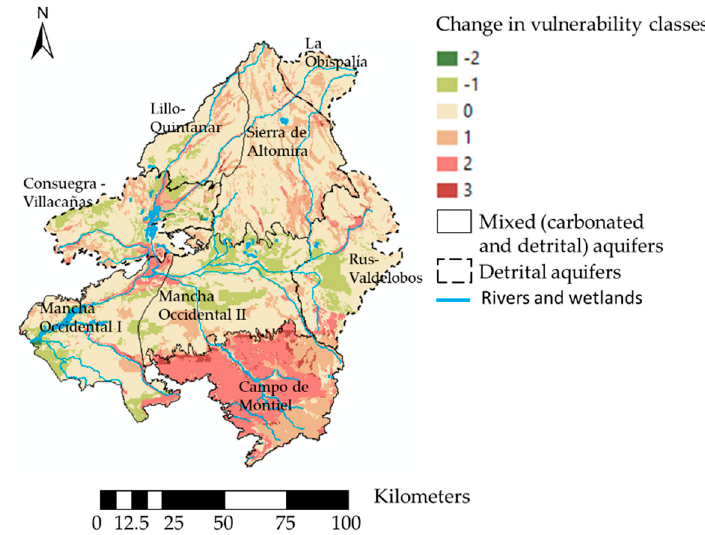
Figure 8. Spatial distribution of change in O-DRASTIC vulnerability classes in comparison to the original DRASTIC.